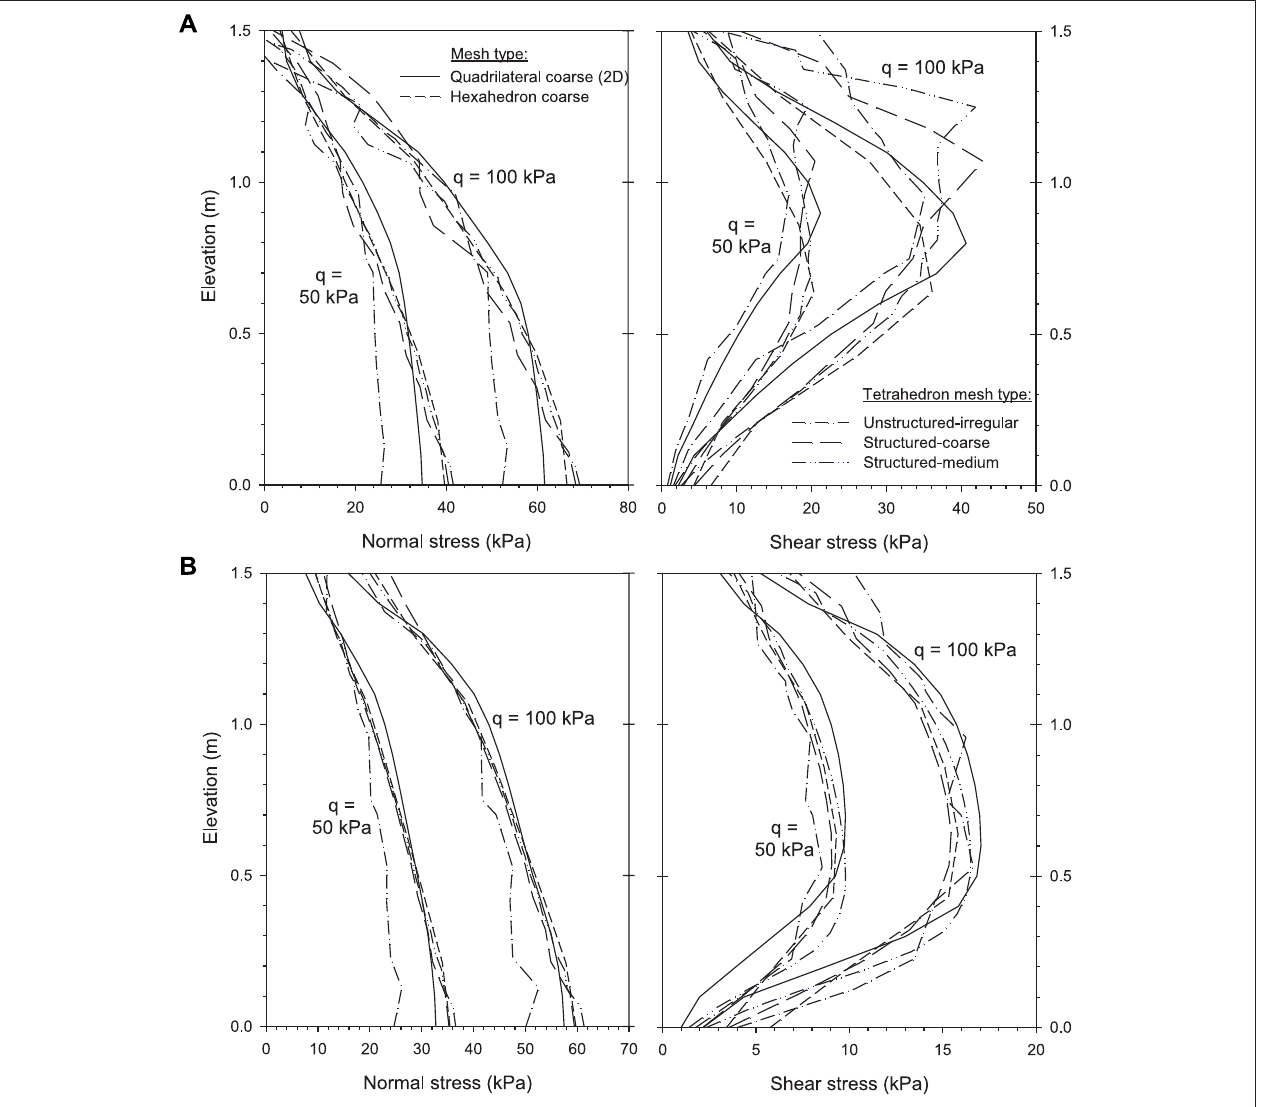
FIGURE 17 | Load transfer from back fi ll soil to facing panel using program CODE_BRIGHT: normal and shear stresses at x = 0.509-m cross-section through the domain with 3D mesh type (coarse and optimized). Cases with (A) Ri = 0.8 and (B) Ri = 0.3.